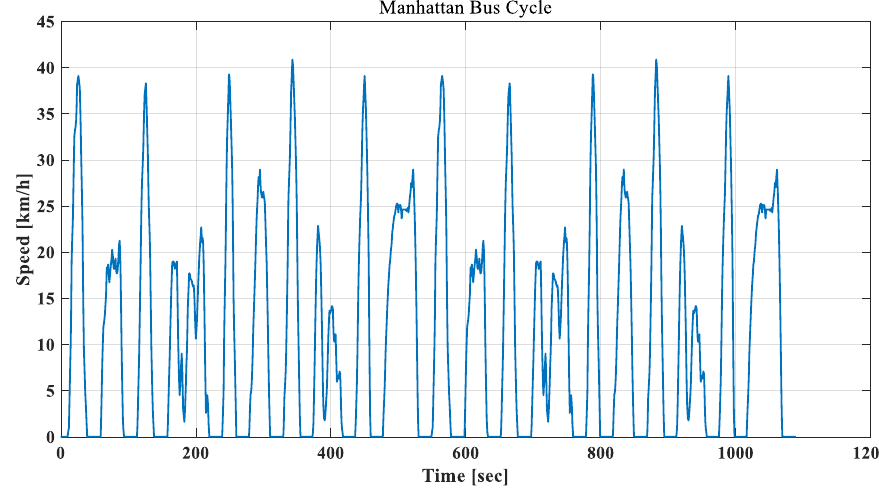
Figure 13. Manhattan Bus Cycle [17].